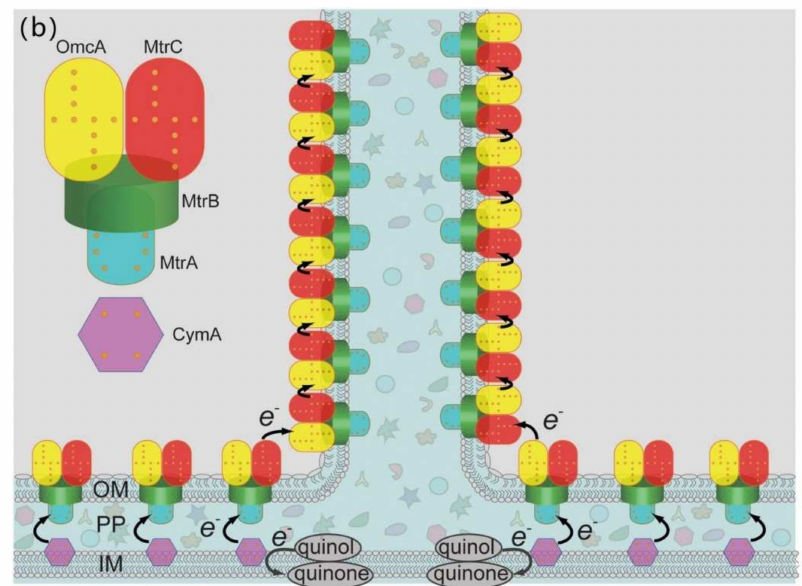
Figure 3. ( a ) Sideroxydans lithotrophicus ES-1 uses c -type cytochromes ( c -Cyts) for direct electron transport. The metal oxidation pathway (Mto) of Sideroxydans lithotrophicus ES-1 is MtoA (a multihaem c -Cyts (mtrA) homolog), MtoB (a porin-like outer membrane protein MtrB homolog), and MtoD (a mono-haem c -Cyt) and CymA (a multihaem c -Cyt), electrons transferred from extracellular Fe(II) to quinone (Q) in the inner cytoplasmic membrane and cytoplasmic membrane, respectively [72]. Reproduced with permission from Springer Nature. ( b ) Proposed structural model for nanowires of S. oneidensis MR-1. S. oneidensis MR-1 nanowires are outer membrane (OM) and periplasmic (PP) extension including various c -type cytochromes such as OmcA, MtrC, MtrB, MtrA, for electron transfer between these cytochromes, thus enabling extracellular electron transfer in bacteria [79]. Reproduced with permission from PANS.